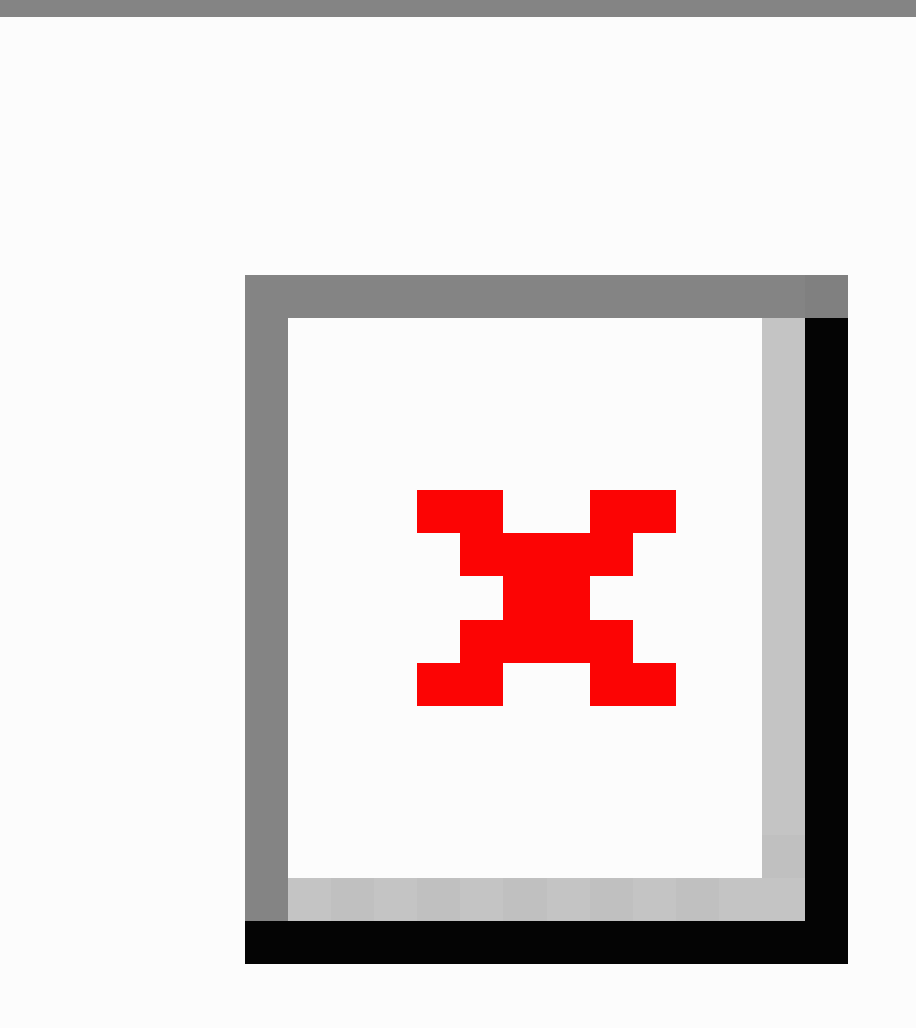
Figure 1. Possible model to explain relationship between adherence and